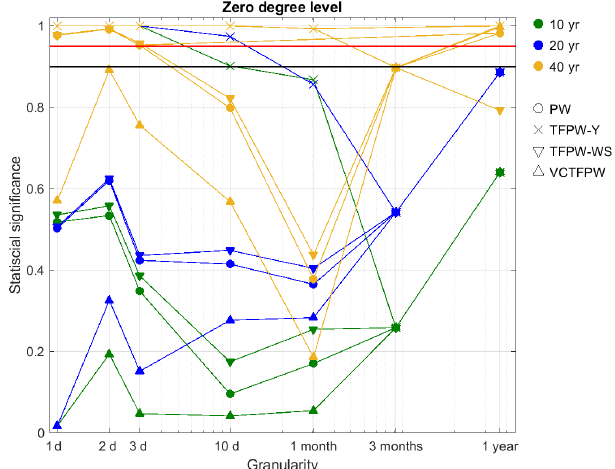
Figure 7. Statistical significance of the trends as a function of the time granularity and prewhitening methods for the zero-degree level time series for 10-, 20- and 40-year periods without temporal seg- mentation to address seasonality. The horizontal red and black lines correspond to the threshold of 95% and 90% confidence levels, re-